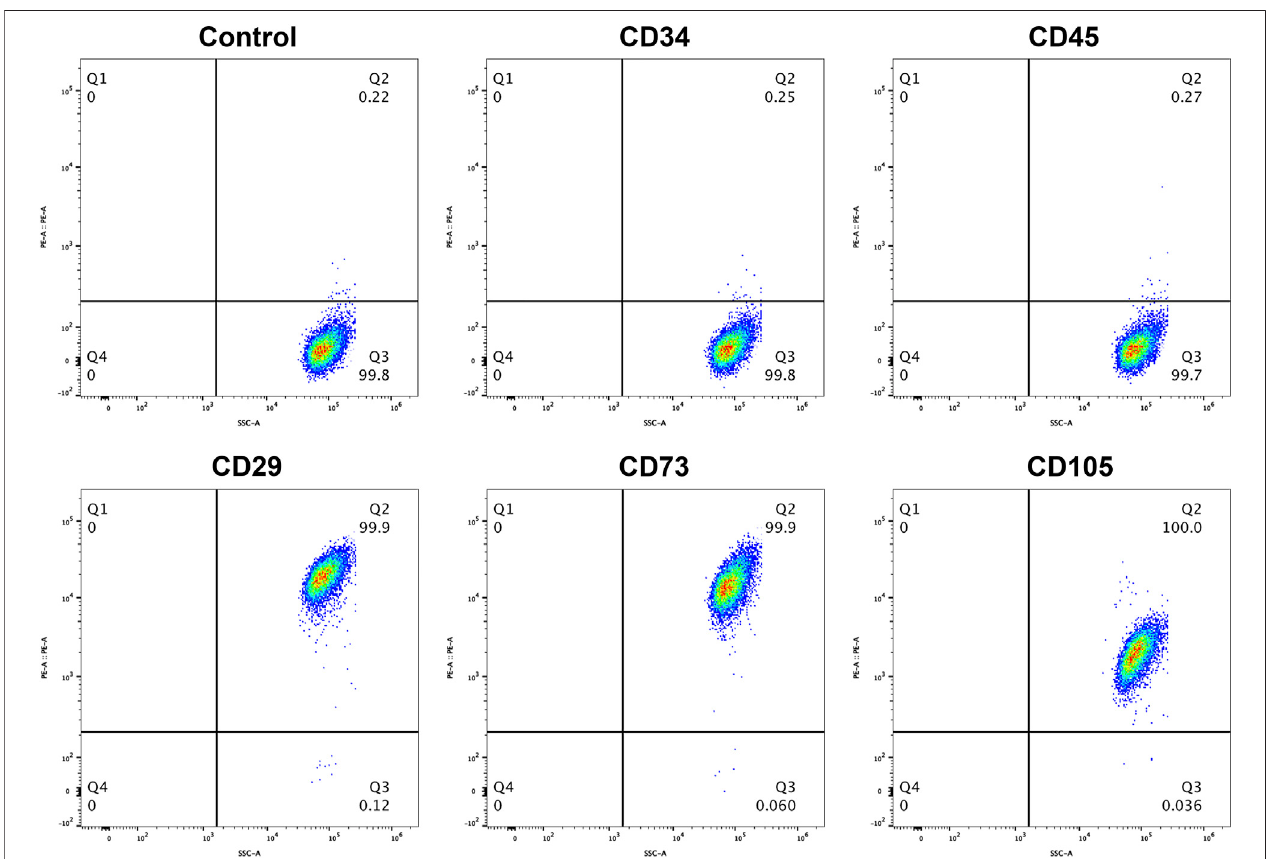
FIGURE 6 | Characterization and fl ow cytometric analysis of hMSCs.